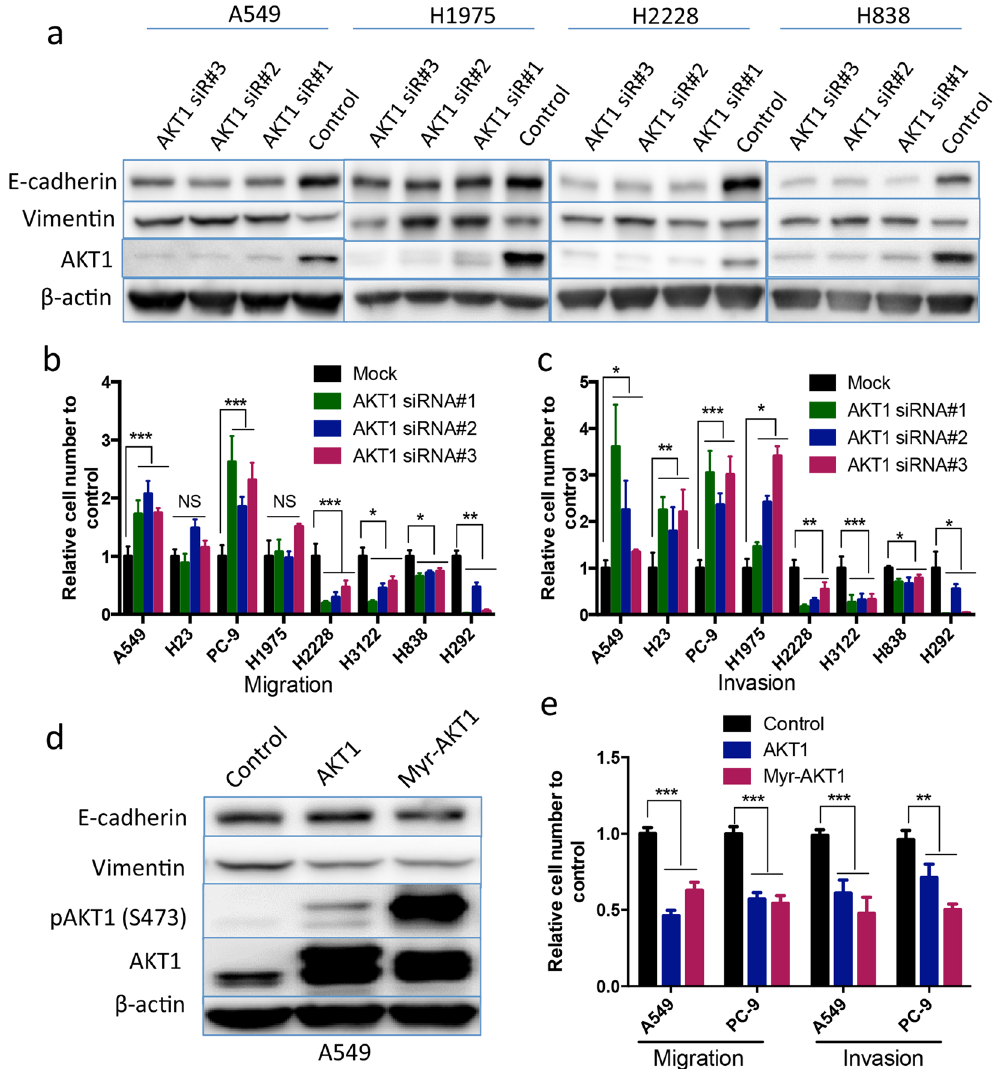
Figure 2. AKT1 inhibits migration and invasion of KRAS or EGFR mutant NSCLC cells. ( a ) Western blot analyses of E-cadherin, Vimentin, and AKT1 in A549, H1975, H2228 and H838 transfected with/without 10 nM of indicated AKT1 siRNA for 48 hours. ( b ) Migration and ( c ) Invasion assays of A549, H23, PC-9, H1975, H2228 H3122, H292 and H838 cells with/without 10 nM of indicated AKT1 siRNA for 48 hours. Graph bar represents mean ± SE. * P < 0.05; ** P < 0.01; *** P < 0.001; and NS: not significant. ( d ) Western blot analyses of E-cadherin, Vimentin, phospho- and total AKT1 in A549 cells transfected with/without wild-type AKT1 or a constitutively active form of AKT1 (Myr-AKT1). ( e ) Migration and invasion assays of A549 and PC-9 cells transfected with the indicated expression plasmid for 24 hours. Experiments were carried out in